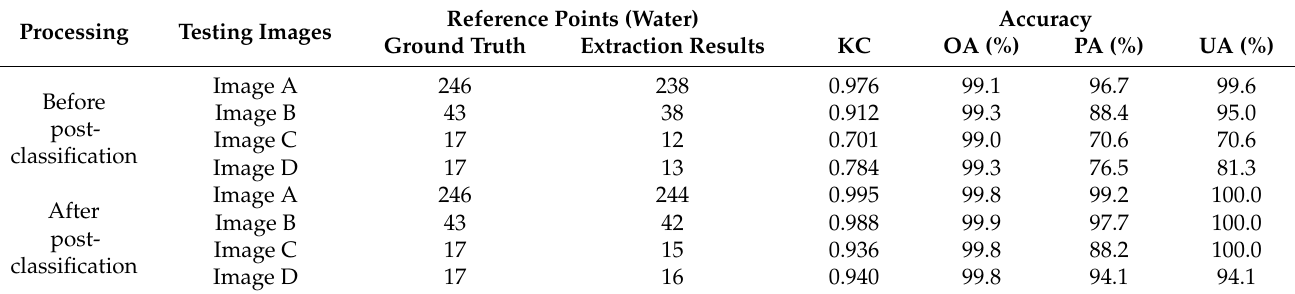
Table 2. Summary of classification accuracies of the method for the four testing images.